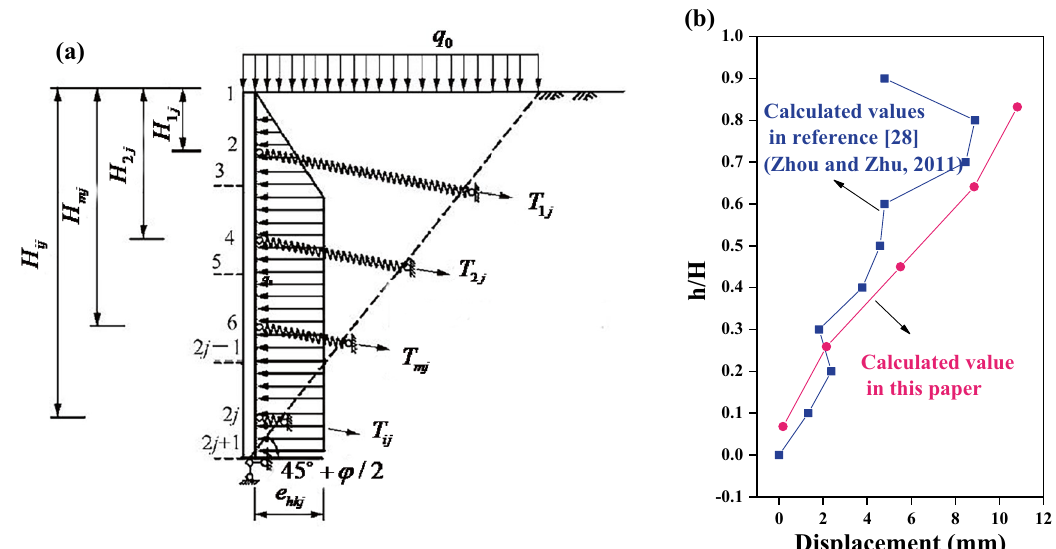
Figure 7. Comparison of theoretical calculation of horizontal displacement 28 ( a ) Computational model; ( b ) Displacement